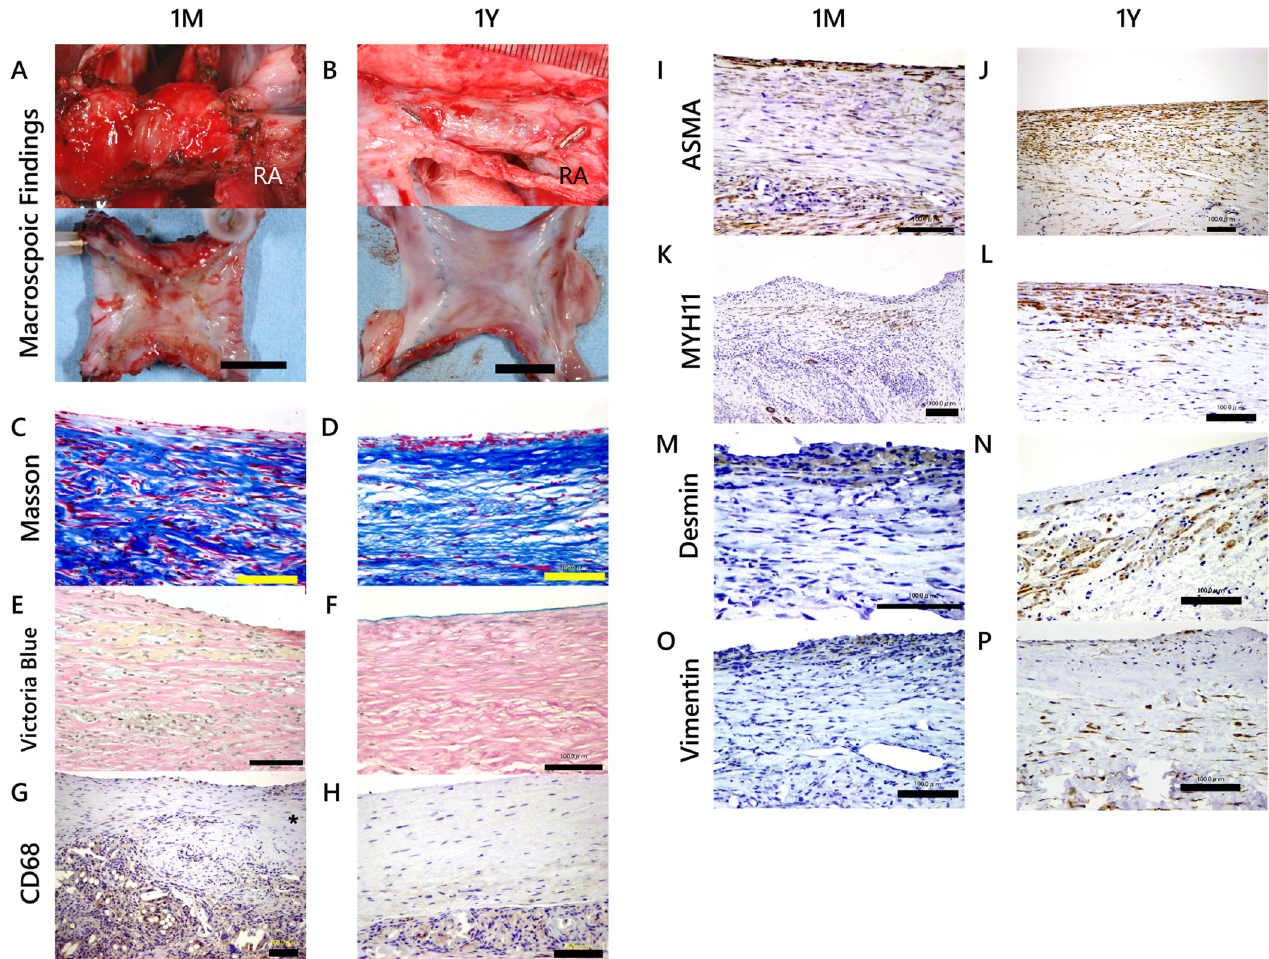
Fig 4. Representative histological sections of iTEV at 1 month and 1 year post-implantation. (A and B) Macroscopic view of 1-month iTEV (A) and 1-year iTEV (B). View of resected iTEV is shown in the lower panel (bars: 1 cm, RA: right atrium). (C and D) Masson’s trichrome and (E and F) Victoria blue staining. (G and H) Inflammatory cells in the specimens of iTEV were identified by immunoexpression against CD68, a known macrophage marker, in developing iTEV (1 month) and mature iTEV (1 year) (bars: 100 μ m). Histological studies revealed that CD68-positive cells were expressed mainly in the vicinity of the LCL fibers and sponge, and some were observed in the neo-intima that developed on the surface of the biodegradable scaffold () (1M; G). In 1-year iTEV, CD68-positive cells were observed on the outer side of the iTEV, which consisted of the remaining scaffold or adhesive tissues (1Y; H). (I and J) α - Smooth muscle actin (SMA), (K and L) myosin heavy chain 11 (MYH11), (M and N) desmin and (O and P) vimentin immunostaining demonstrate differences in expression in vascular smooth muscle cells (VSMCs) and intermediate filaments in developing iTEV (1 month) and mature iTEV (1 year) (bars: 100 μ m). α - SMA expression is clearly visible at 1 month and 1 year, but MYH11, desmin, and vimentin are not clearly observed in 1-month iTEV. Mature VSMCs and intermediate filaments are more visible in 1-year iTEV.